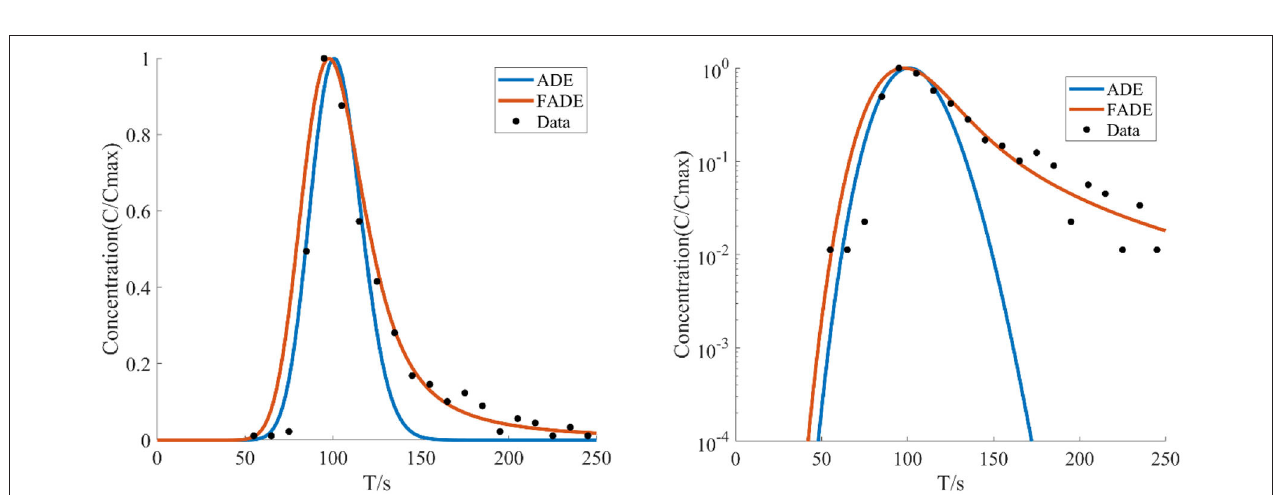
FIGURE 6 | The average flow rate is v = 7.924 mm/s, the crack width is B = 7mm, the BTCs are fitted by ADE model and FADE model.